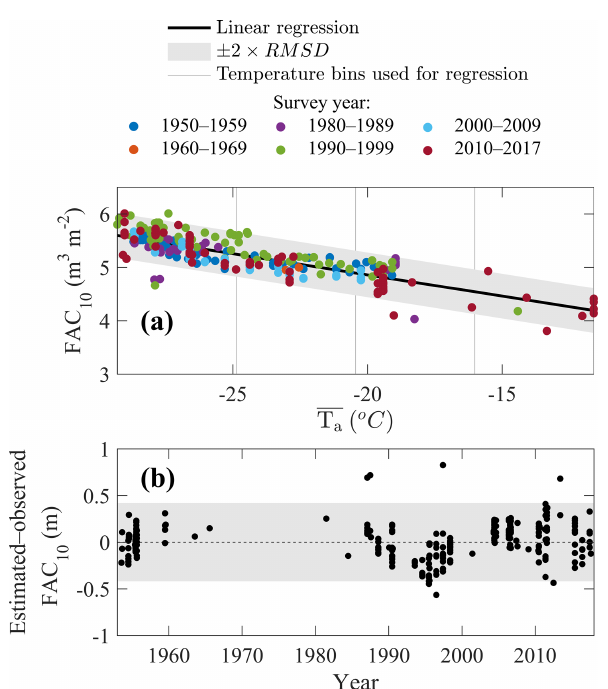
Figure 2. (a) Linear function of T a fitted to FAC 10 observations from the DSA and upper HAPA. (b) Residual between estimated (using linear regression) and observed FAC 10 as a function of sur- vey